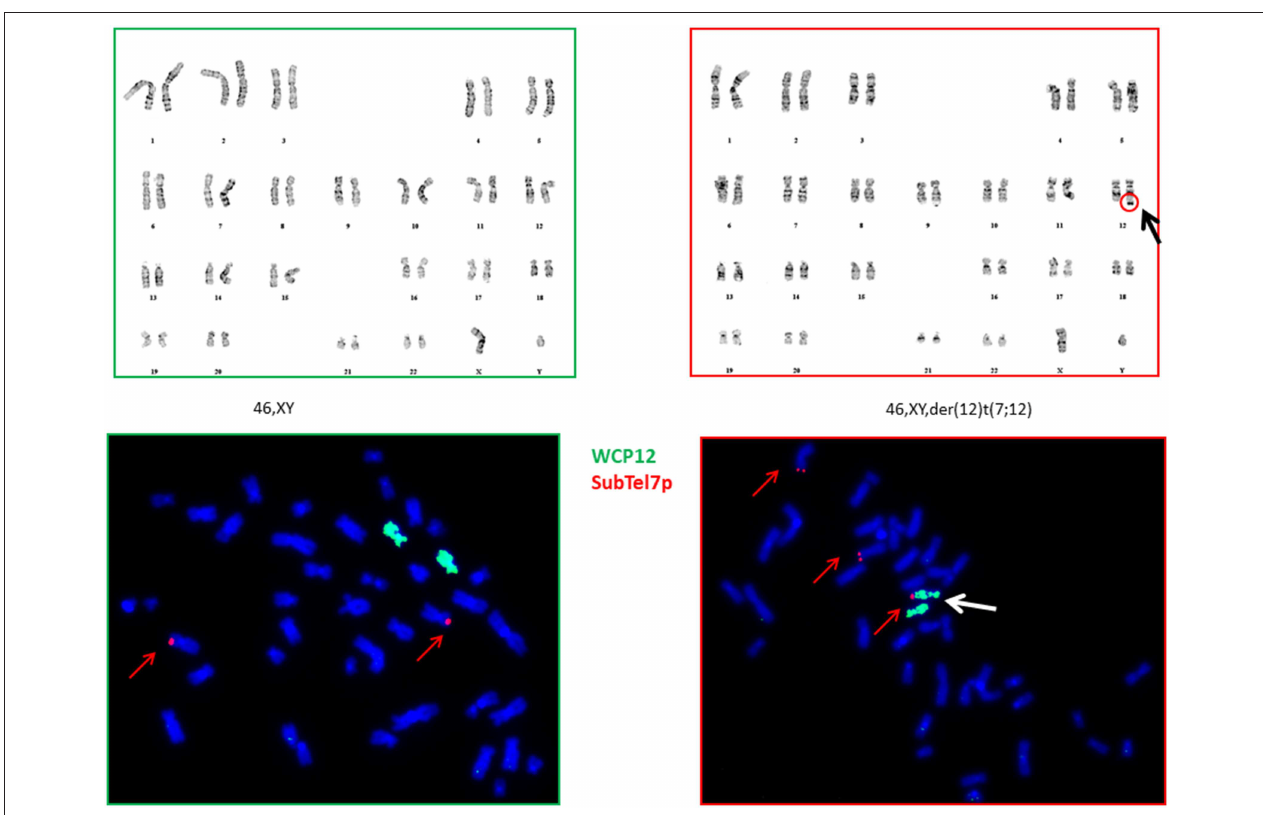
FIGURE 2 | Karyograms and FISH analysis of 2E8 and 3D5 clones. Karyograms: Chromosomal analysis (karyotyping) of G-401 cell line showed a normal karyotype in clone 2E8 (46,XY) on left side and a derivative chromosome 12 as sole anomaly in metaphases of clone 3D5 on right side (46,XY,der(12)t(7;12)(p?14;q?24) (upper part) . FISH data: FISH analysis of clones with a normal and aberrant karyotype (2E8 on left side and 3D5 on right side) with commercially available probes WC (Whole Chromosome) 12 (green) and Sub-Telomere 7p (red) revealed an additional 7p segment at the telomeric site of q-arm of one of chromosome 12 (partial trisomy 7p), inducated with a white arrow (lower part)